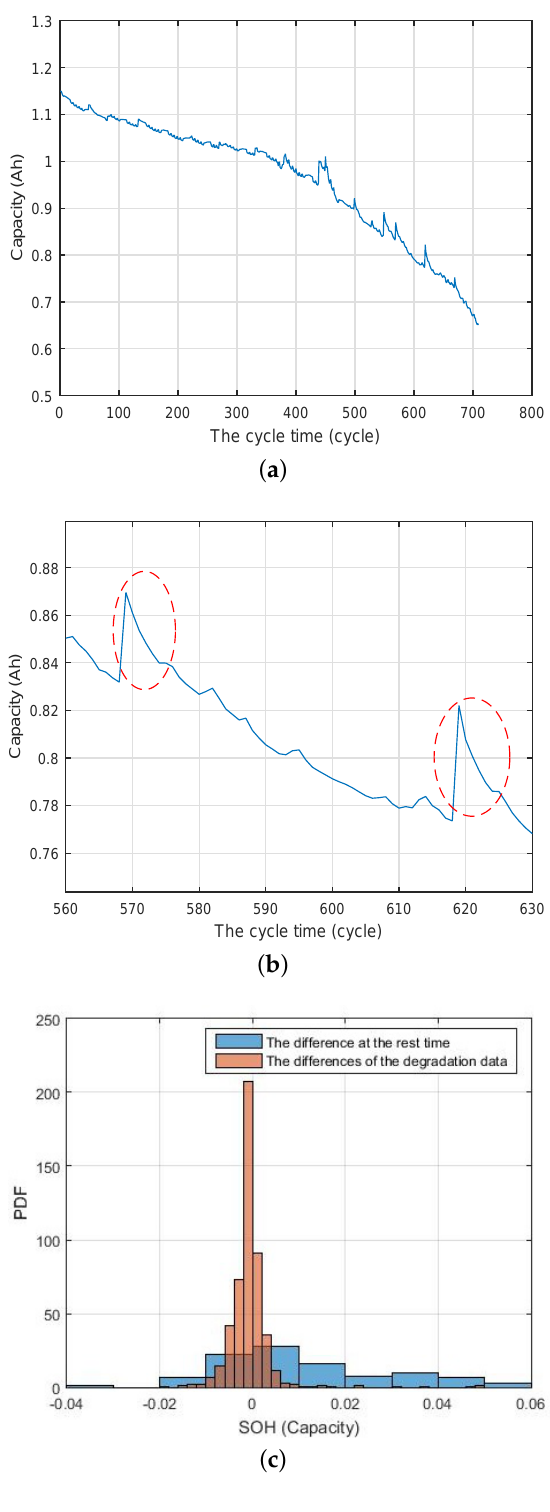
Figure 1. The degradation trajectory of the battery. ( a ) The degradation of battery capacity; ( b ) The regeneration phenomena in the degradation process; ( c ) The degradation difference between the rest time and